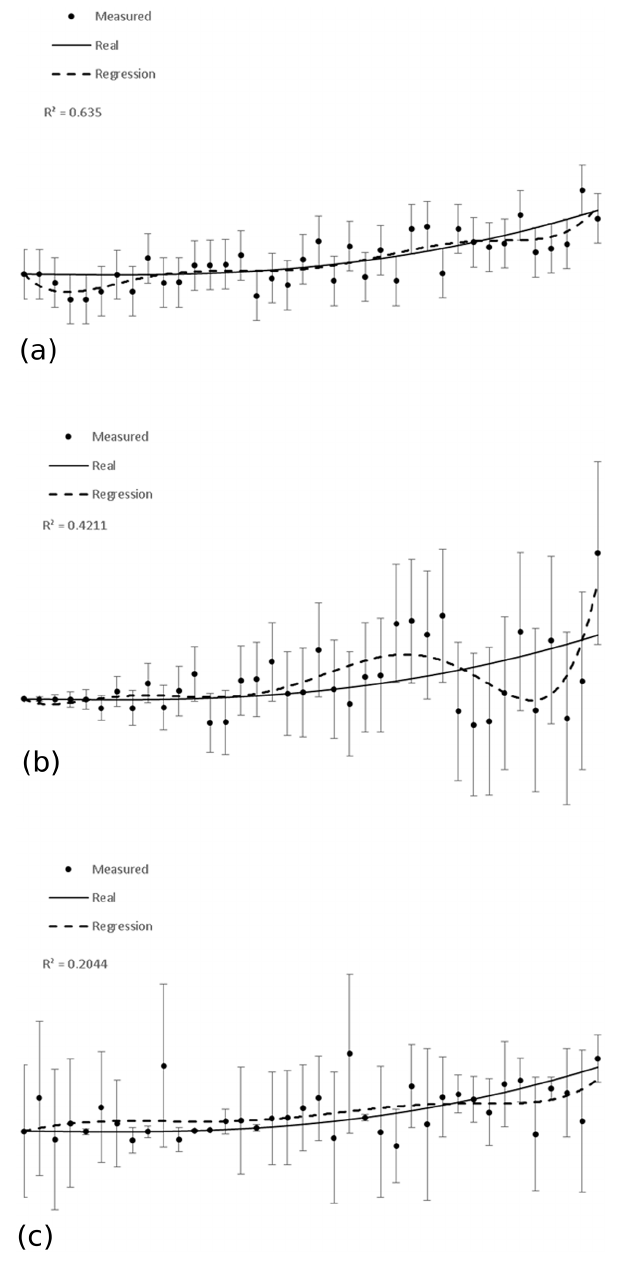
Figure 4. Synthetic examples of different levels of scedastic- ity of measurements of the same variable. (a) Homoscedastic case, (b) structured heteroscedastic case and (c) unstructured het- eroscedastic case. Note how the least-square polynomial residual score ( R 2 ) is heavily impacted by scedasticity.